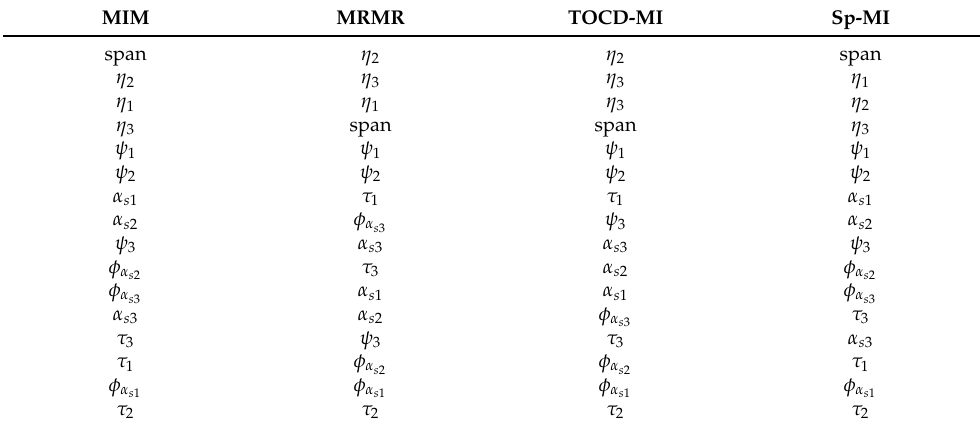
Table 3. Parameter ranking result of the Xi’an area based on different methods of mutual